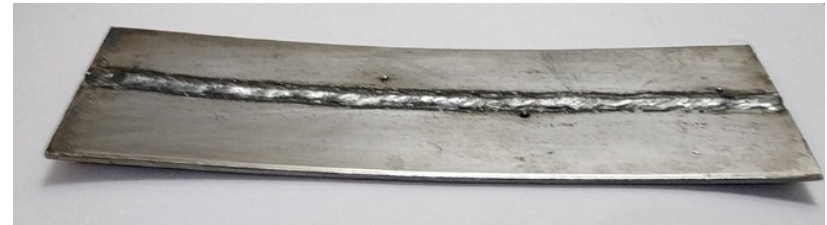
Figure 13. The weld sample for validation .